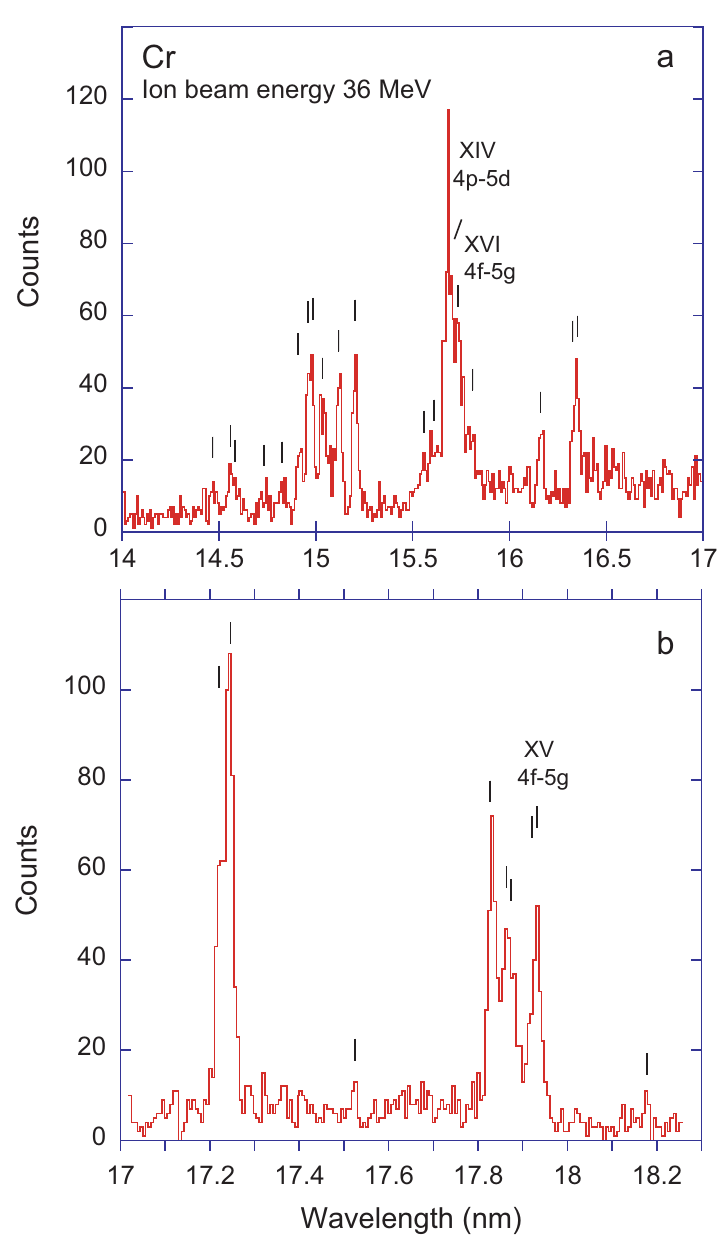
Figure 13. Detail sections ( a,b ) of the beam-foil spectrum of Cr shown in Figure 12. Ion beam energy 36MeV. Observation at the foil. Line width (FWHM) 0.035nm. Fiducial markers point to visually recognised spectral features, most of which have not yet been identified. Several spectral features can be tentatively identified with yrast transition